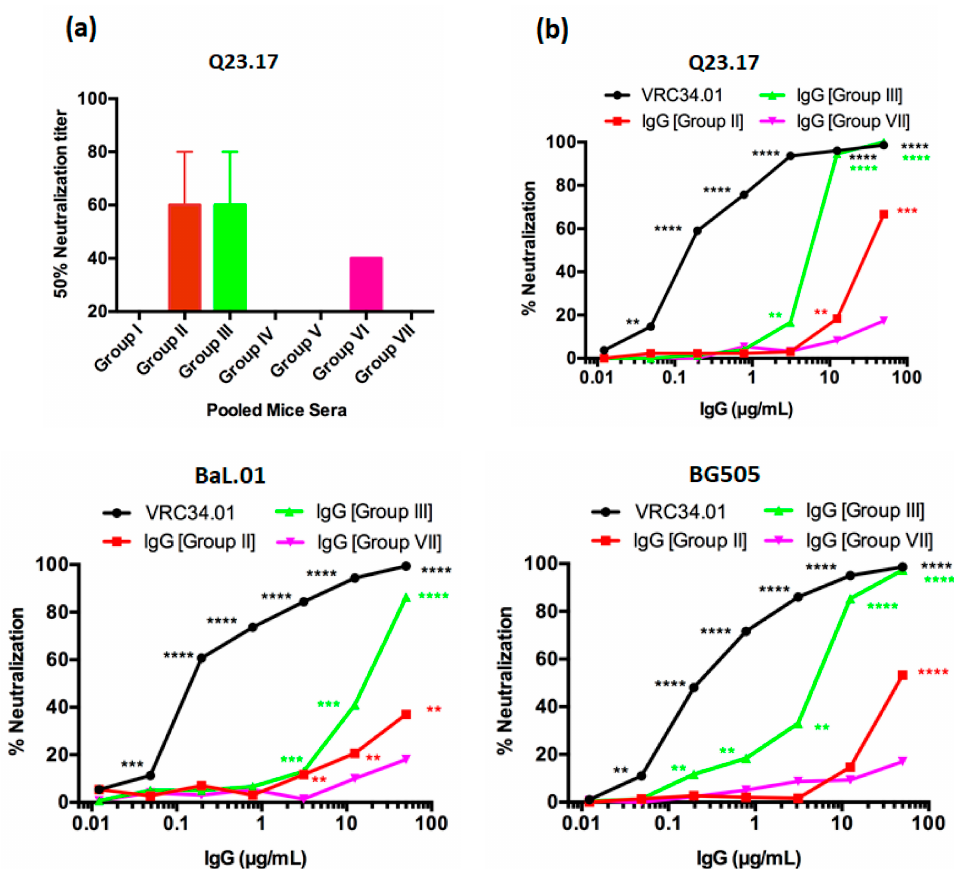
Figure 5. Neutralization activity of pooled sera ( a ) or pooled purified IgG ( b ) from FP8-VLP immunized mice. In vitro neutralization activity was determined using TZM-bl cells infected with Q23.17 (Clade A), BG505 (Clade A) and BaL.01 (Clade B) HIV-1 virus. (a) Neutralizing activity of pooled week 8 sera obtained from BALB / c mice immunized with various prime-boost-boost compositions containing FP8-VLPs alone or FP8-VLPs and BG505 DS-SOSIP was determined against Q23.17. The neutralization titer is expressed as the reciprocal of the highest serum dilution reducing cell infection by 50%. The lowest dilution tested was 1:20. (b) The viral neutralization activity of dilutions of purified serum IgG obtained from FP8-VLPs immunized mice with di ff erent prime boosting regimens was determined against Q23.17, BG505, and BaL.01, and is presented as percentage neutralization. VRC34.01 (positive) and IgG from Q β / MS2 VLP immunized mice (negative) were used as controls. p values were calculated by paired two-tailed t test. **, p < 0.01, ***, p < 0.001, ****, p <